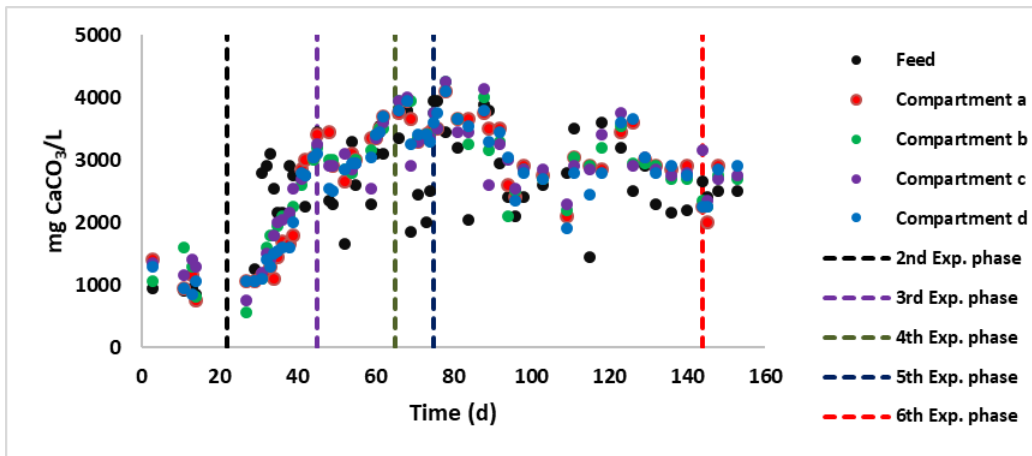
Figure 7 . Daily total alkalinity value of the feedstock and reactor compartments. Table 4. Average daily pH and total alkalinity of the feedstock, compartments and